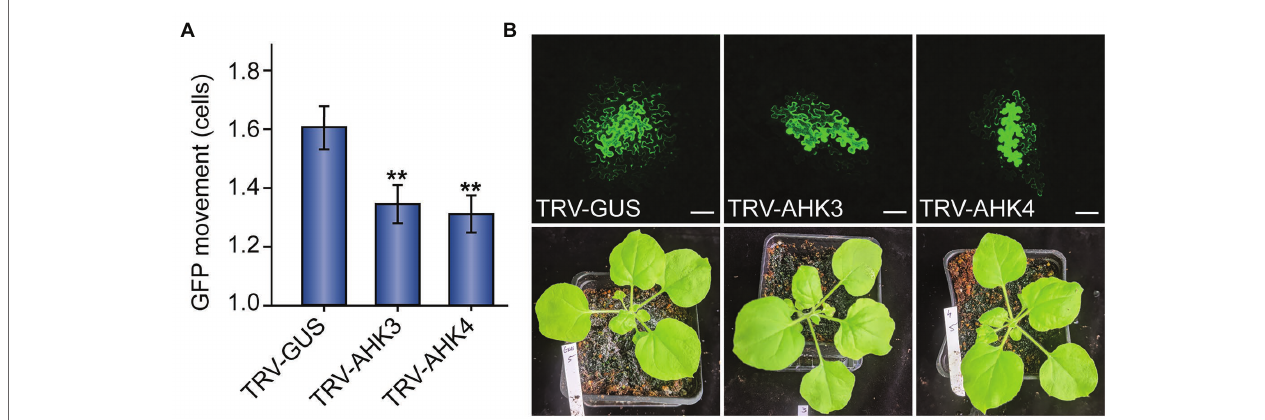
FIGURE 2 | Virus-induced gene silencing (VIGS) of cytokinin receptor expression reduces PD-mediated GFP movement in N. benthamiana leaves. (A) Compared to control TRV-GUS plants, GFP movement from transformed cells was significantly lowered in plants where the cytokinin receptors AHK3 or AHK4 were silenced ( n = 124, ** p < 0.01; or n = 133, ** p < 0.01; respectively; error bars indicate SEM). (B) Representative confocal images of transformed N. benthamiana cells and examples of 5-week-old VIGS-treated plants indicate that GFP movement was reduced in AHK3 and AHK4 -silenced plants, but there were no obvious phenotypic effects on the plants themselves. In mock-treated TRV-GUS plants, GFP typically moved 1–3 cells beyond the transformed cell; in AHK3 and AHK4 -silenced plants, GFP movement rarely exceeded two cells. The fourth leaf from 5-week-old N. benthamiana plants was used for each experiment; white scale bars = 100 μ m.